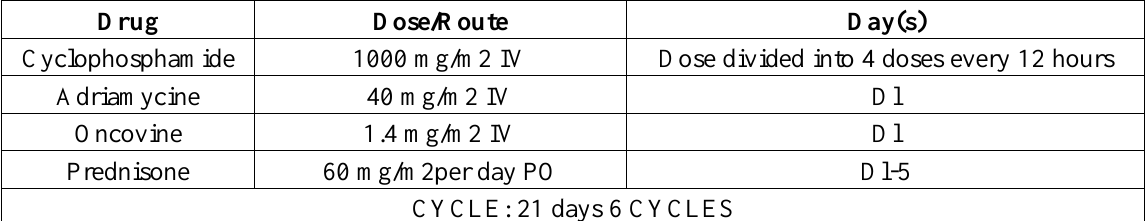
Table 2. COP AD (Cyclophosphamide, Oncovine, Doxorubicin and Prednisone) Protocol for Localized Non Hodgkin Lymphoma for Group A.